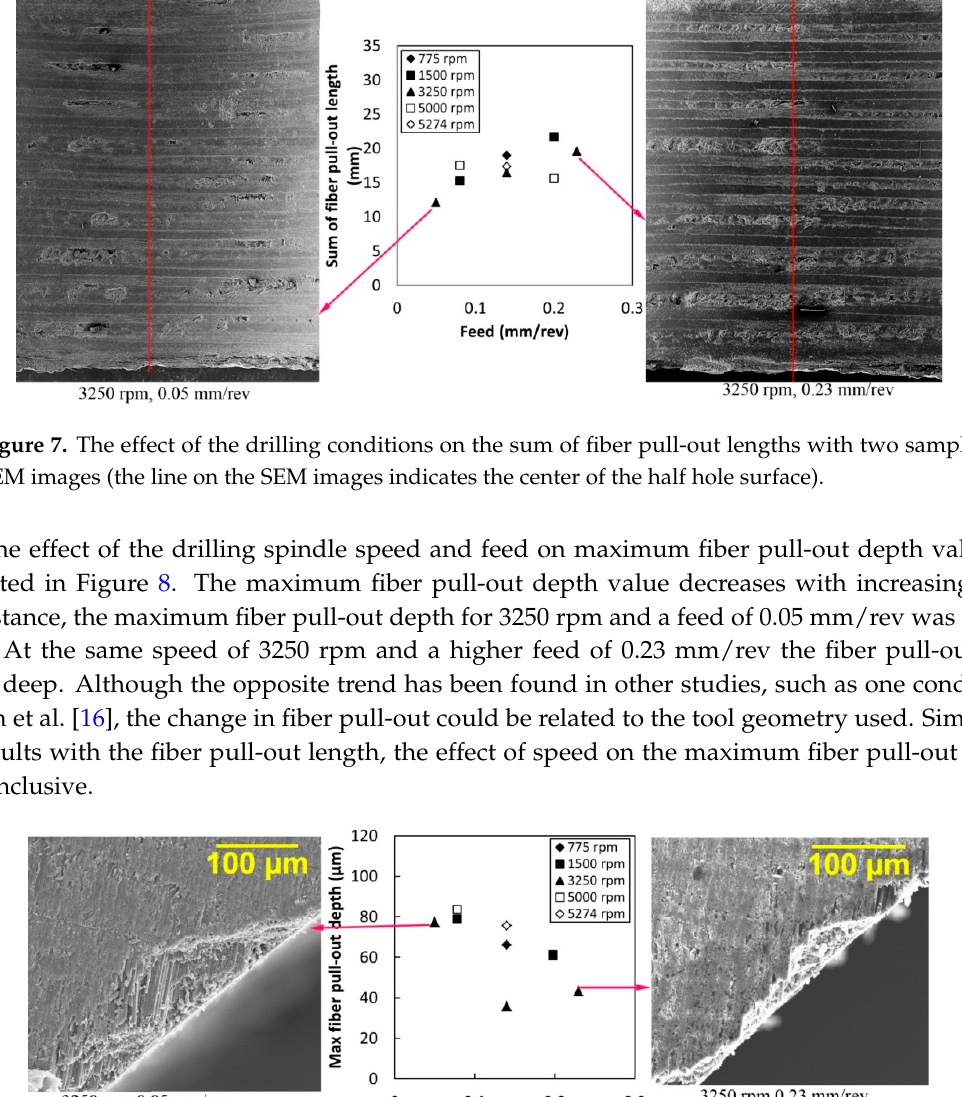
Figure 8. The effect of the drilling conditions on the maximum fiber pull-out depth with two sample SEM images.